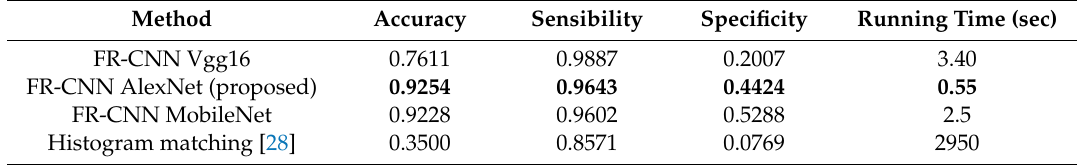
Table 3. OD detection performance comparison among three methods using our own dataset.